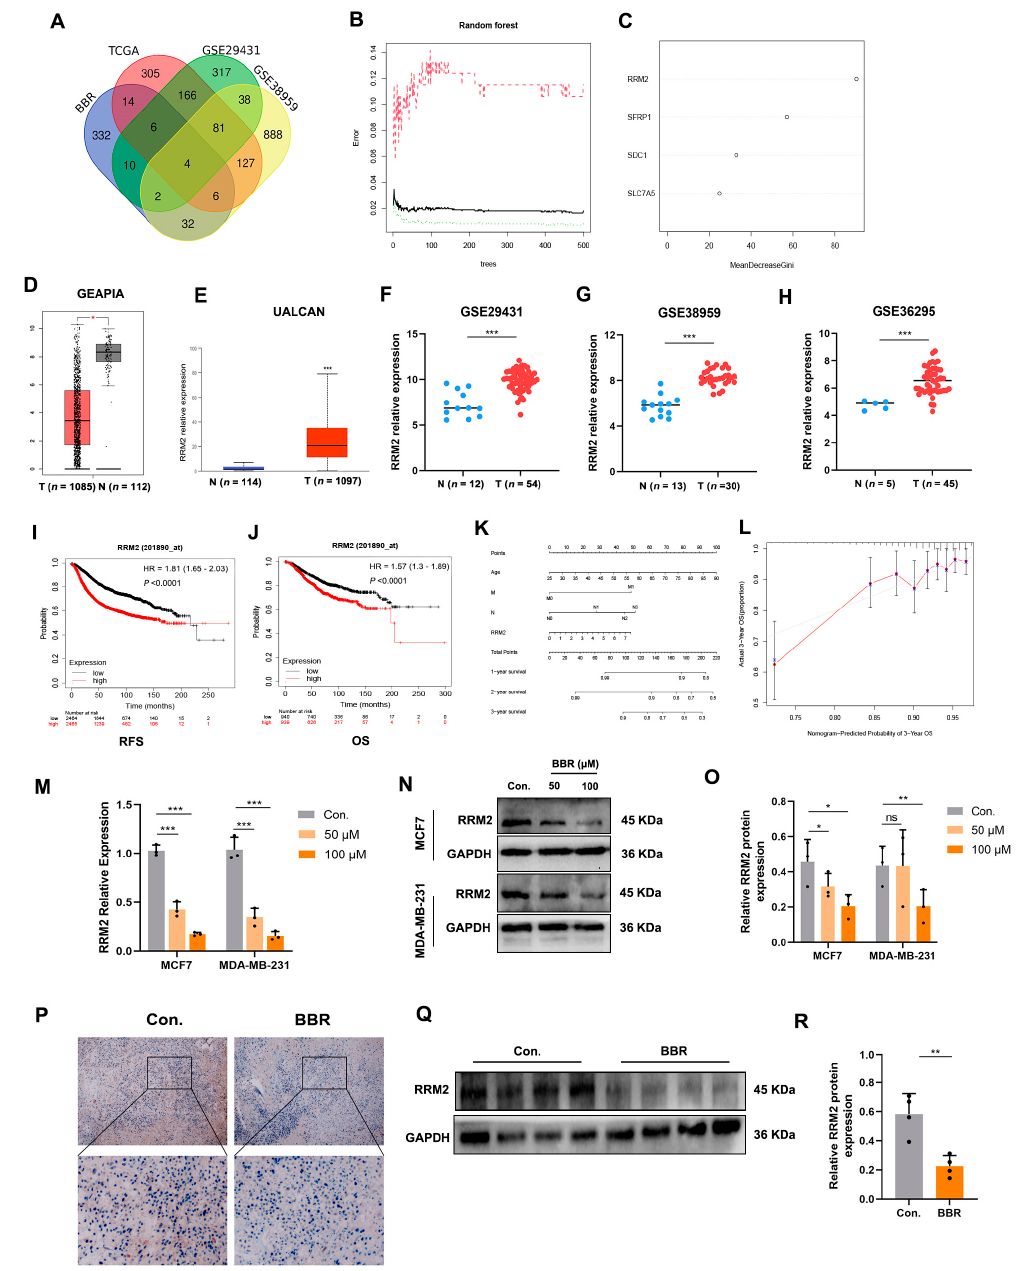
Figure 4. RRM2 as a potential regulator in BBR-treated BRCA cells . Venn diagrams depict DEGs associated with clinical significance and BBR targeting information in different transcriptome matrices ( A ). The influence of the number of decision trees on the error rate. The x-axis represents the number of decision trees, and the y-axis indicates the error rate ( B ). Results of the Gini coefficient method in the RF algorithm ( C ). Results of the Gini coefficient method in the RF classifier. The gene (RRM2) ranked in the top list according to the prognostic importance was chosen for further analyses. Multiple transcripts showed that RRM2 was highly expressed in BRCA tissues ( D – H ). The survival curves of RFS and OS ( I , J ). The nomogram for predicting the 3-year OS of BRCA patients ( K ). The calibration curve for the OS nomogram model ( L ). The ideal nomogram approximates the tilt of a gray line. rt-PCR and Western blot indicated that RRM2 expression was downregulated by BBR in MCF7 and MDA-MB-231 ( M – O ). Immunoblotting and Western blotting confirmed that RRM2 expression decreased in xenograft models ( P – R ). * p < 0.05, ** p < 0.01, *** p < 0.001. Data represent the means ± SD of three independent experiments. Representative images show high or low expressions of RRM2 in MDA-MB-231 xenograft tumor tissues. Scale bars: 2 µ m ( O